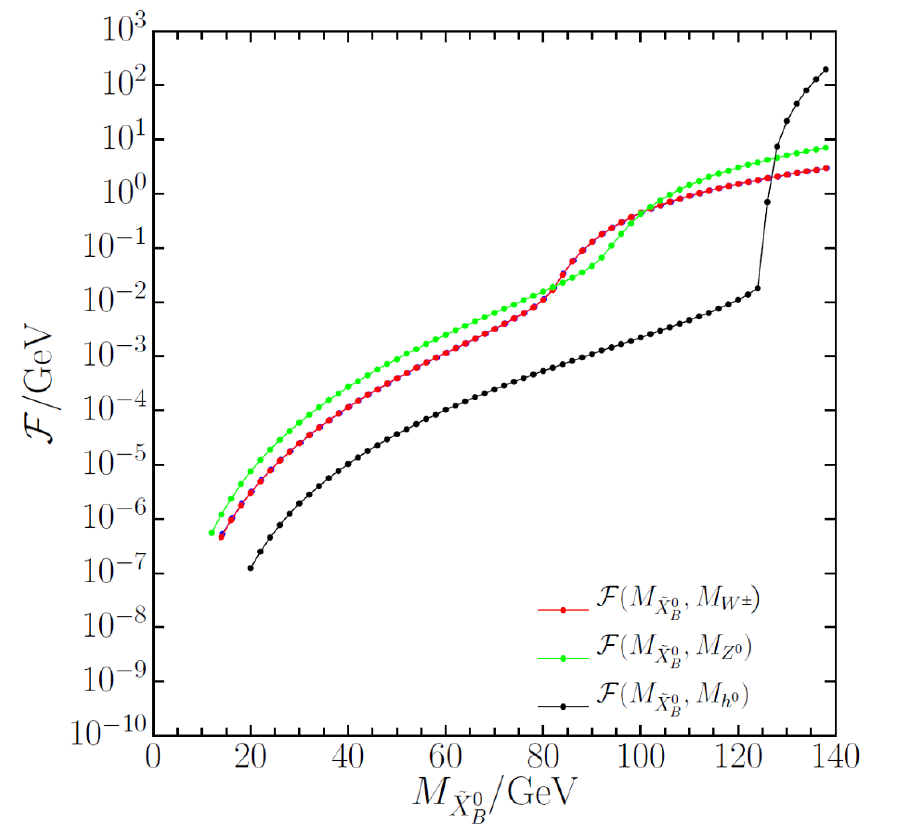
Figure 11. Mass functions F ( M ~